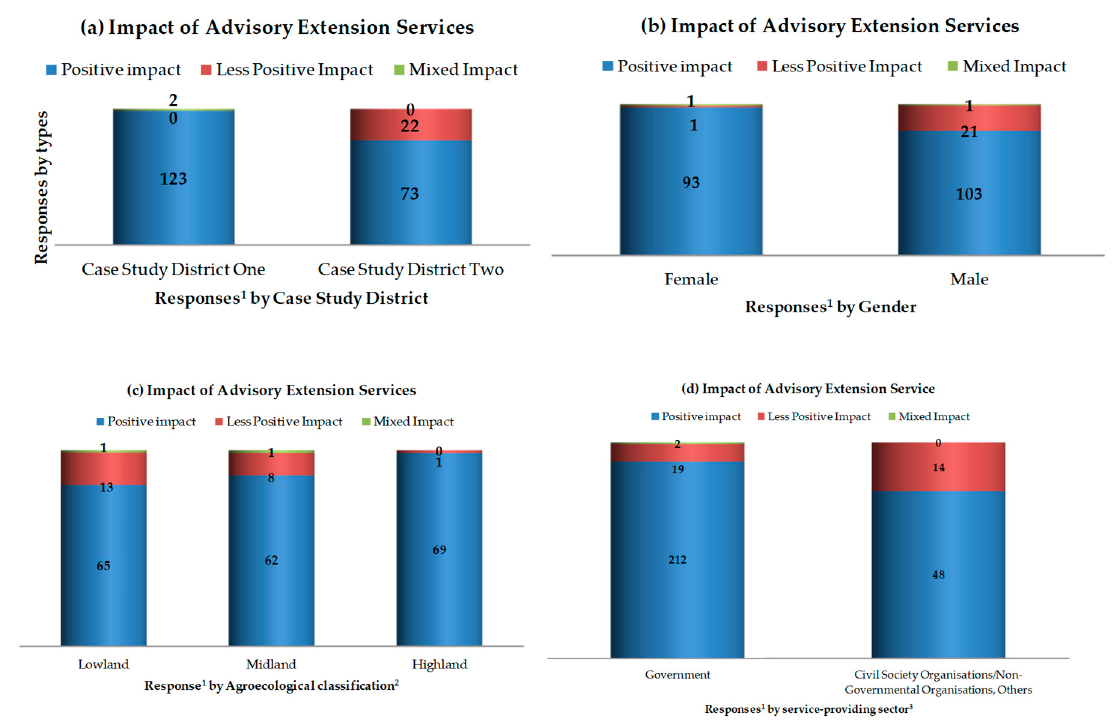
Figure 3. Impact of Advisory Extension Services (positive or less positive 1 ) (questionnaire